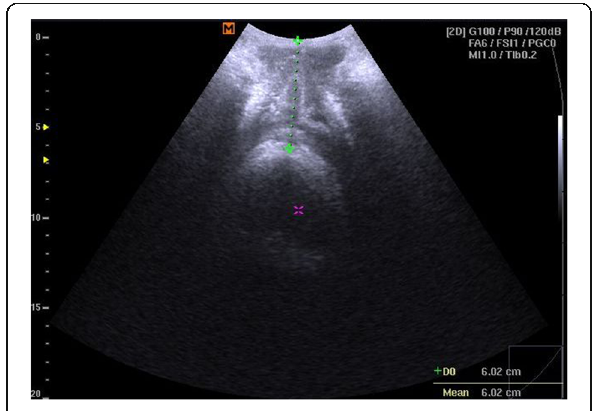
Fig. 3 Fetal head perineum distance. HPD is 6.02 cm rounded down to 6 cm measured transperineally in the transverse view from the outer bony limit of the fetal skull to the